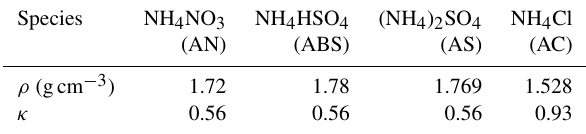
Table 1. Densities ( ρ ) and hygroscopicity parameters ( κ ) of inor- ganic